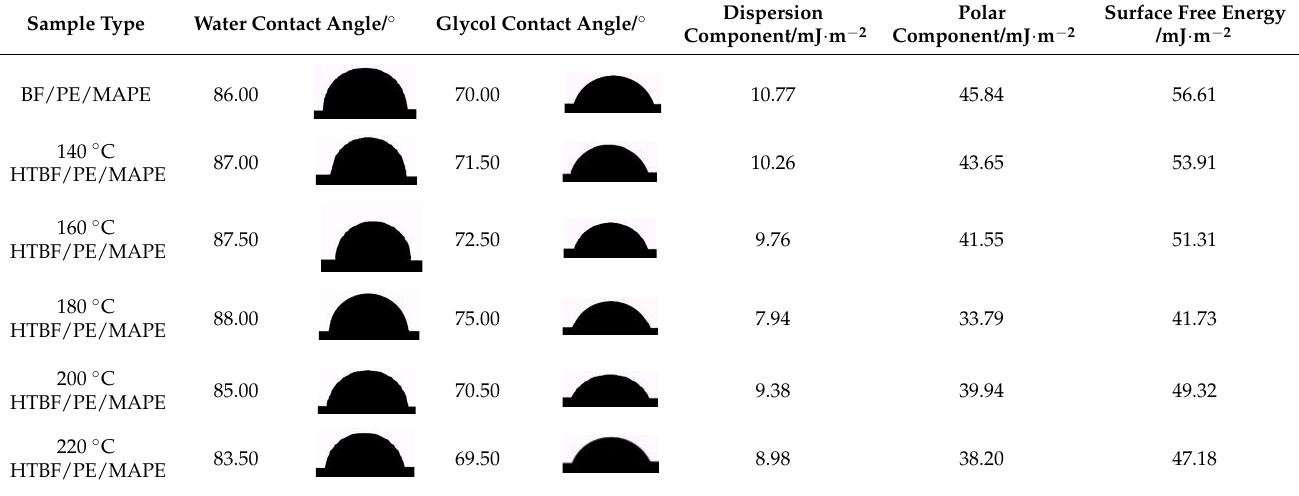
Table 5. Contact angle and surface free energy of BF/PE